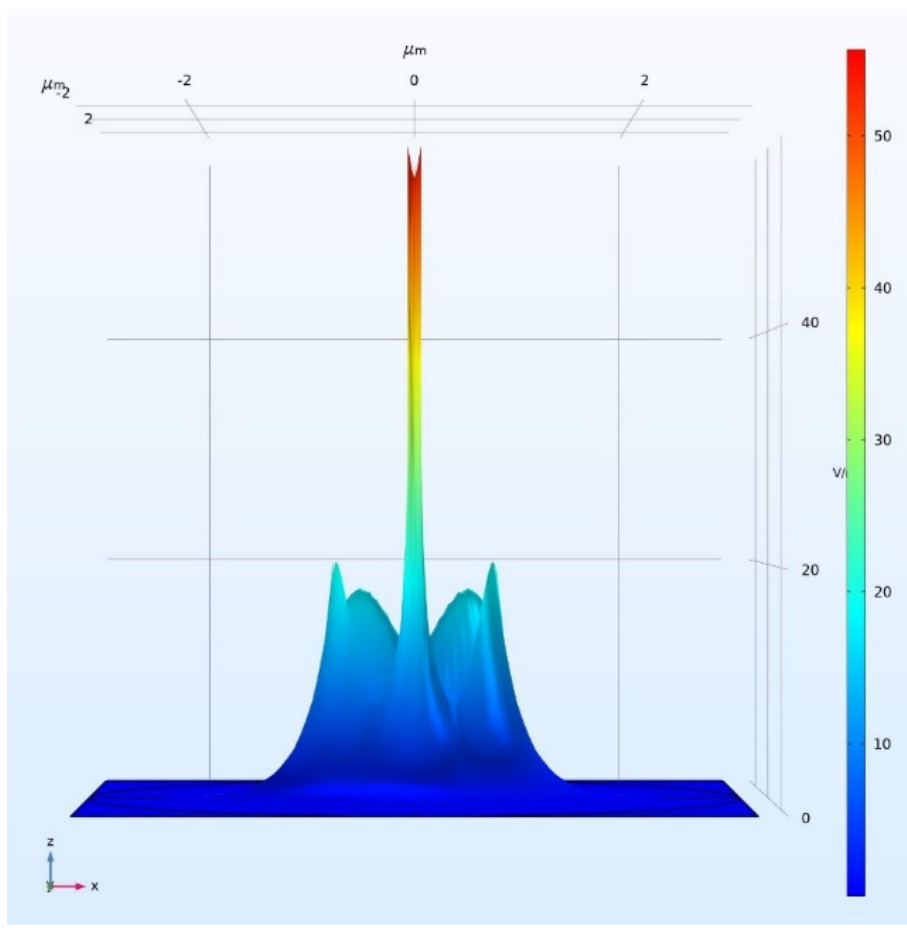
Figure 8. The high expression of norm electric field distribution with 120 nm slot width by assuming TE polarization at 3 µm wavelength.